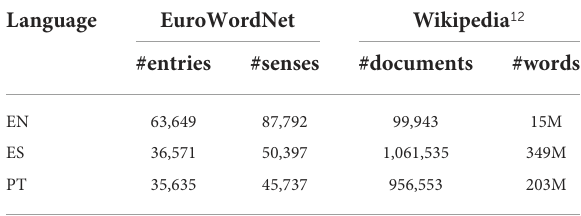
TABLE 4 Statistics of the EuroWordNet thesaurus and the Wikipedia collections processed for the TUNER-LS